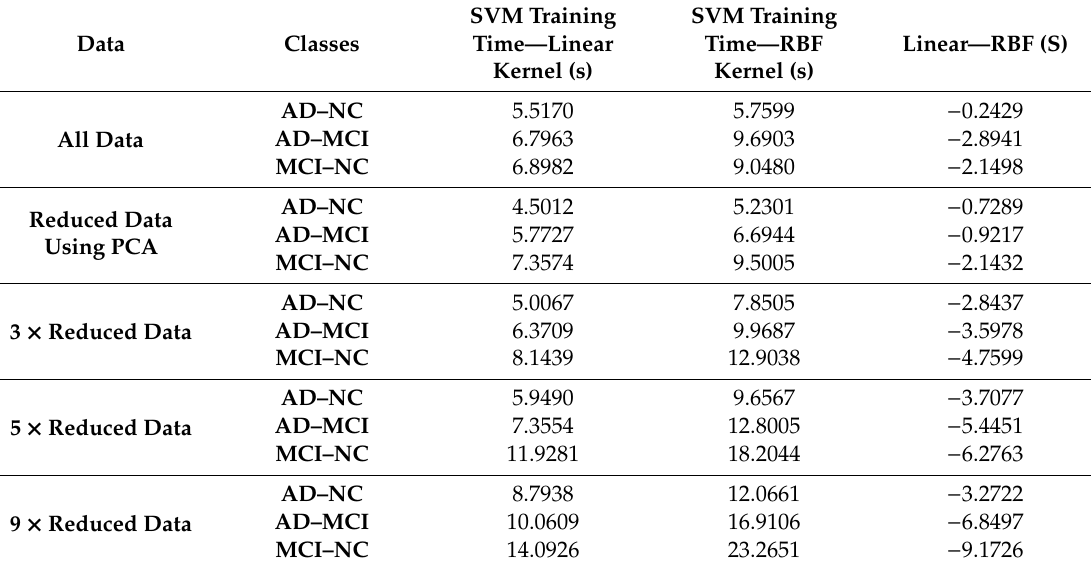
Table 4. Time complexity of SVM with linear kernel vs. Radial Basis Function (RBF) kernel.